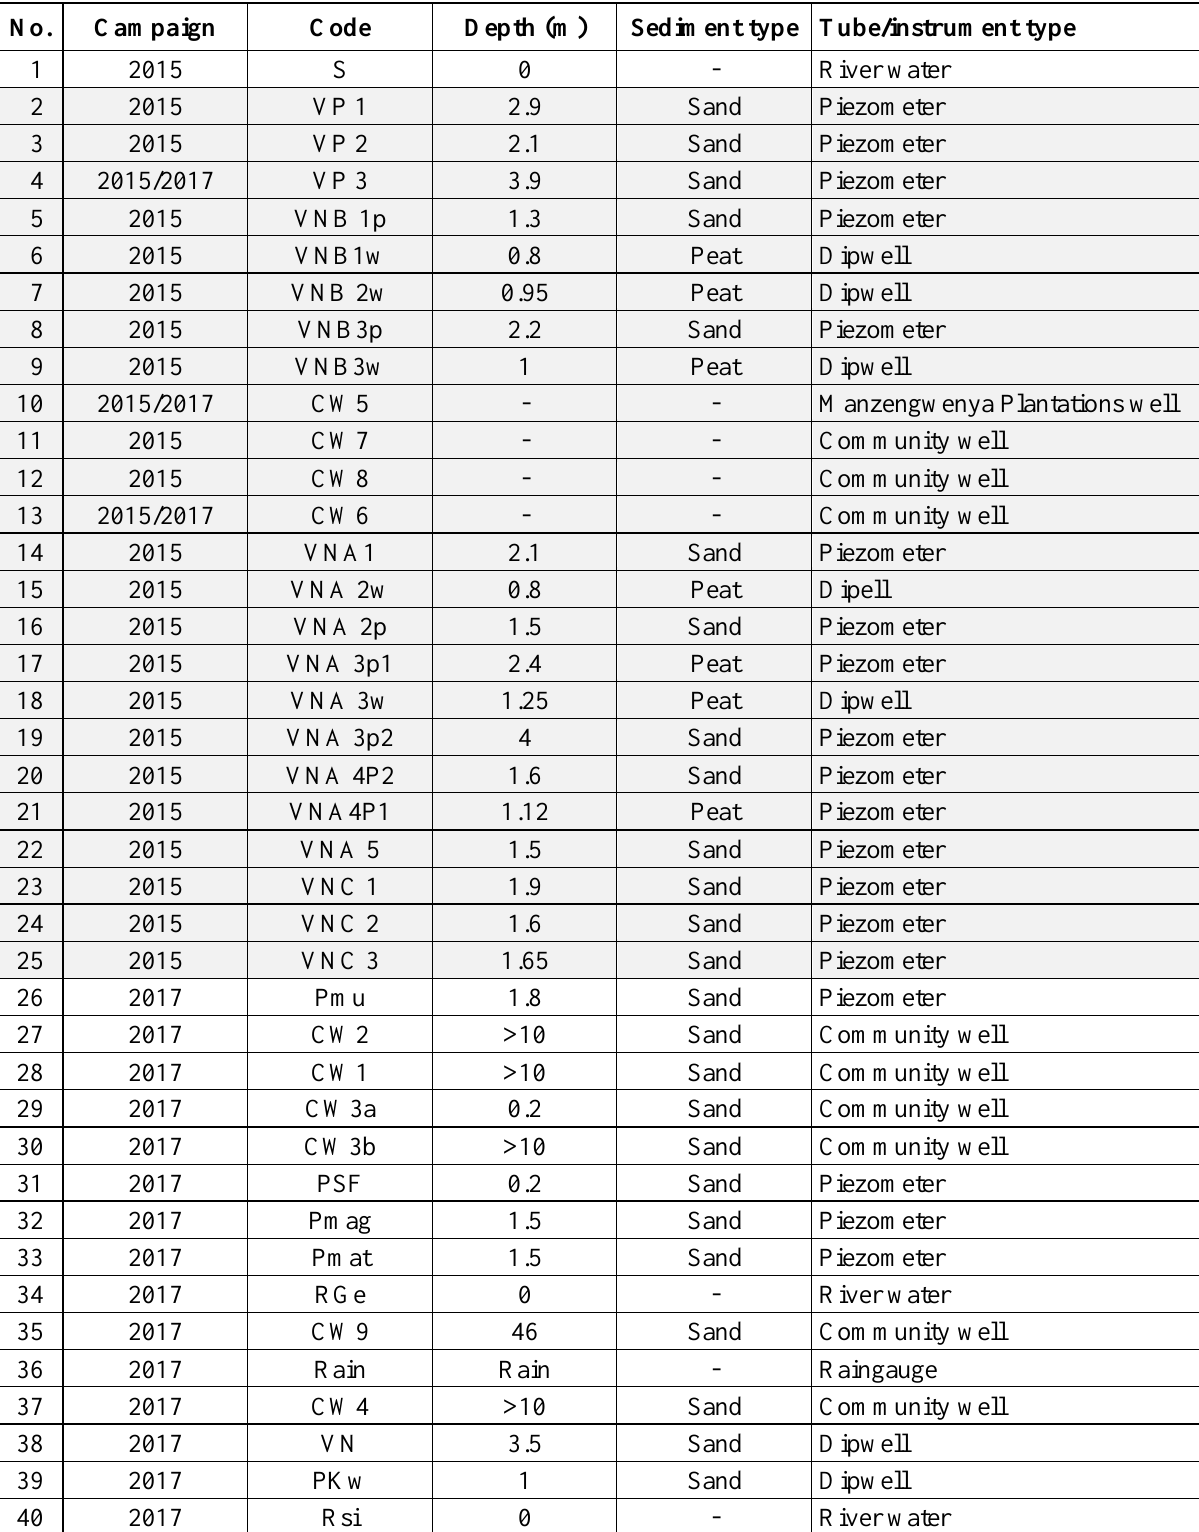
Table A1. Overview of the observation tubes, their types, diameters, and depths and the sediment type Shaded cells indicate the tubes used during the 2015 sampling